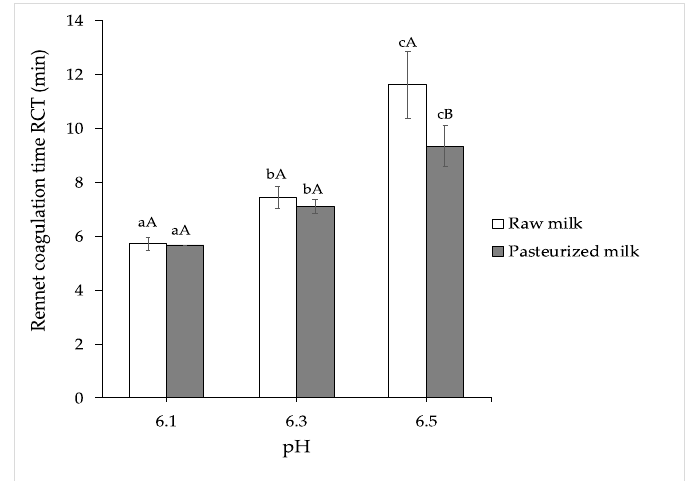
Figure 4. Influence of milk pH and heat treatment of milk on rennet coagulation time RCT (min). Values with different lowercase letters (a, b, c) represent differences between levels of milk pH, different uppercase letters (A, B) represent differences between milk heat treatments (raw/pasteurized). Comparison of means was performed by LSD test ( p < 0.05).